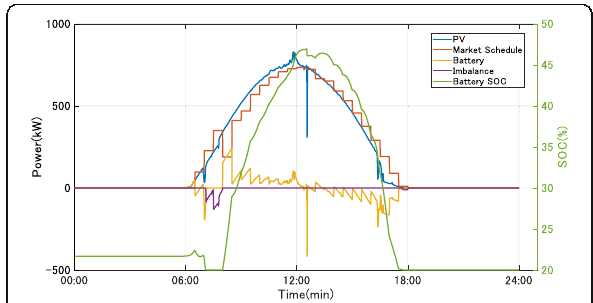
Fig 2 (Abstract P12). Dispatch control for BES at case 4